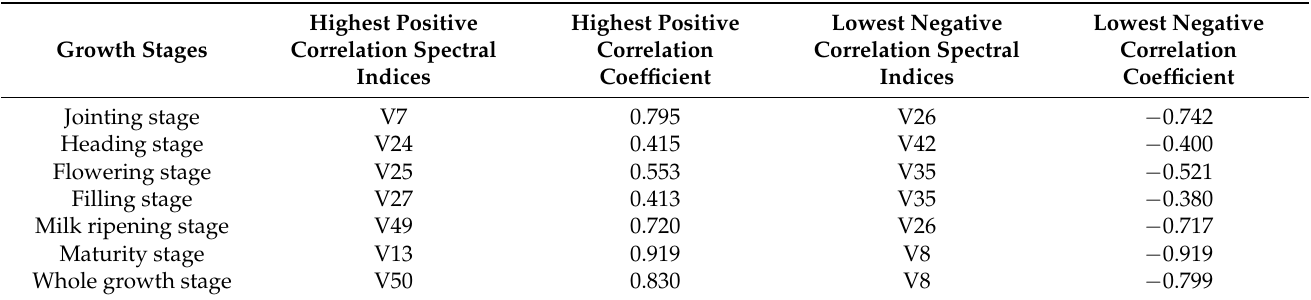
Table 4. Sensitive spectral indices.